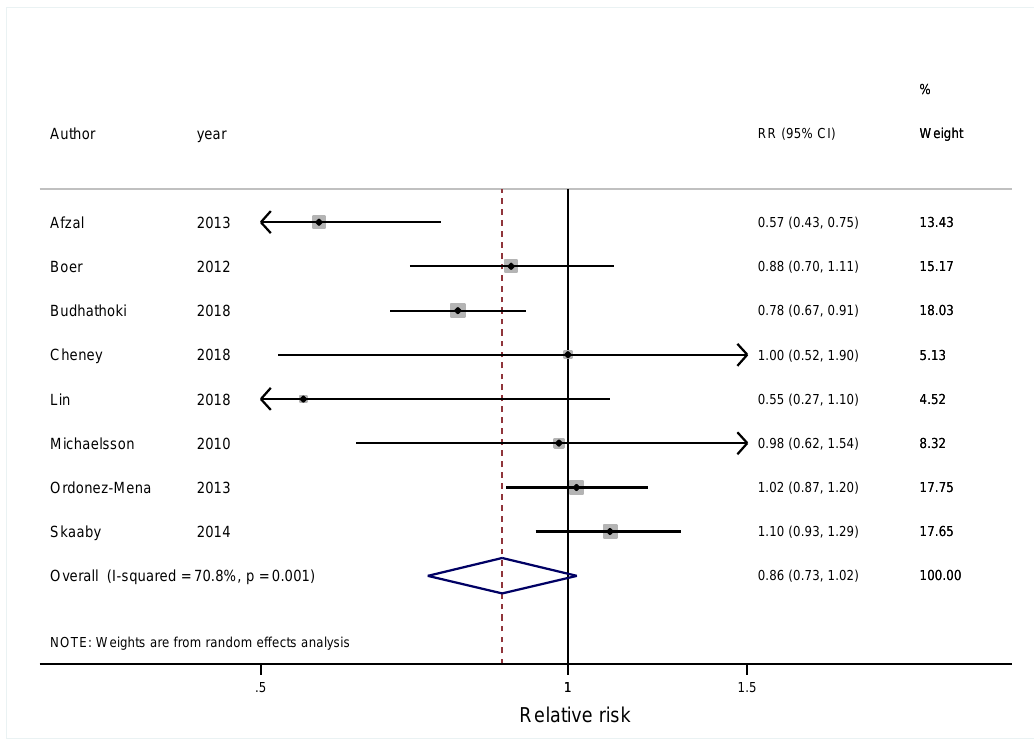
Figure 2. Forest plot to quantify the association between 25-hydroxyvitamin D and total cancer incidence. The summary relative risk was calculated using a random-effects model. The diamonds denote the summary risk estimate, and the horizontal lines represent 95% confidence interval (CI). Abbreviations: RR, summary relative risk.